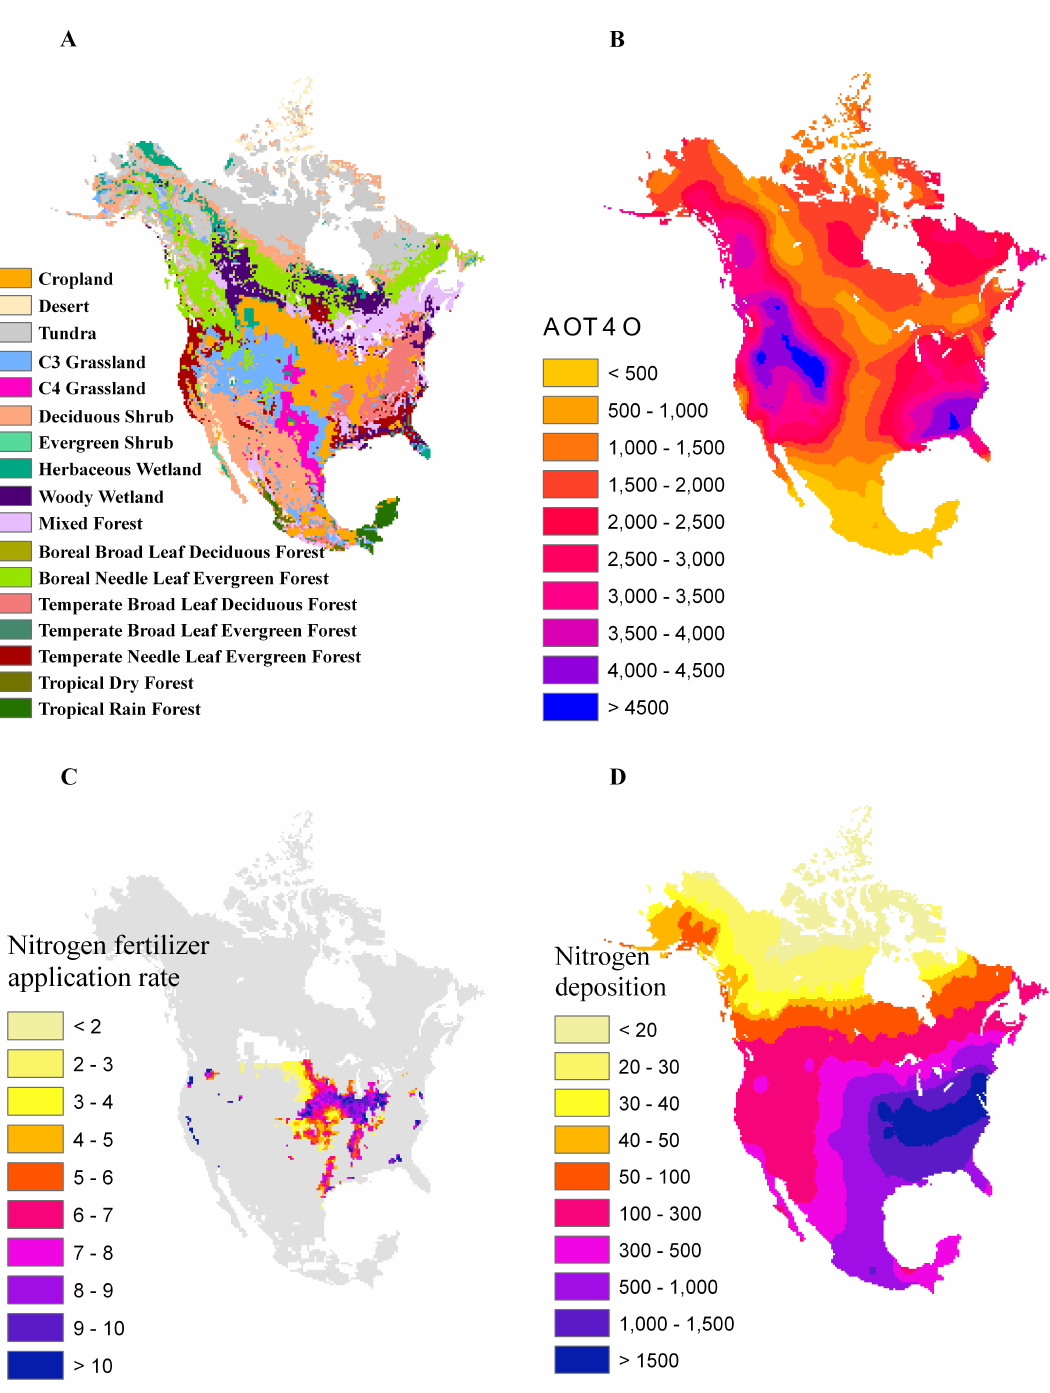
Fig. 2. (A) Contemporary vegetation map, and spatial distribution of 30-year averages of (B) monthly O 3 pollution (ppb–hr), (C) N fertilizer application (gNm − 2 a − 1 ) , and (D) N deposition rate (mgNm − 2 a − 1